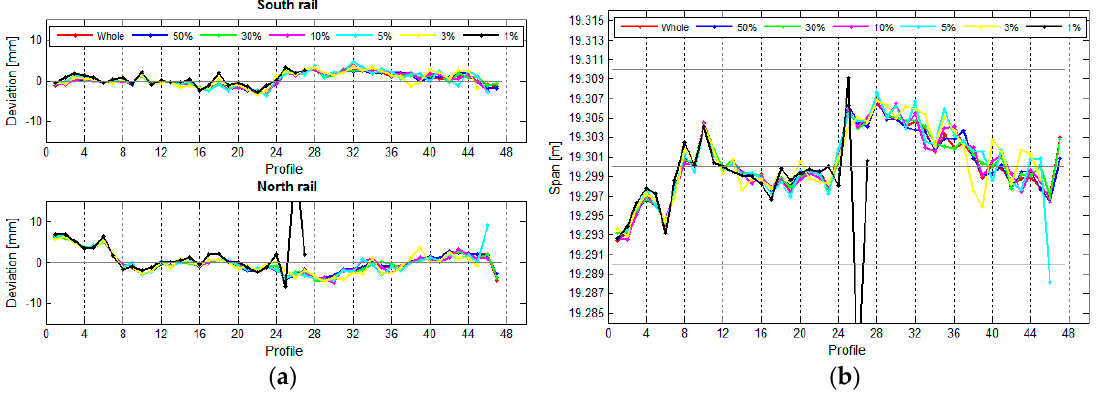
Figure 21. ( a ) The positional deviations of the two rails and ( b ) the spans in relation to the point density. Sensors 2017 , 17 , 1671